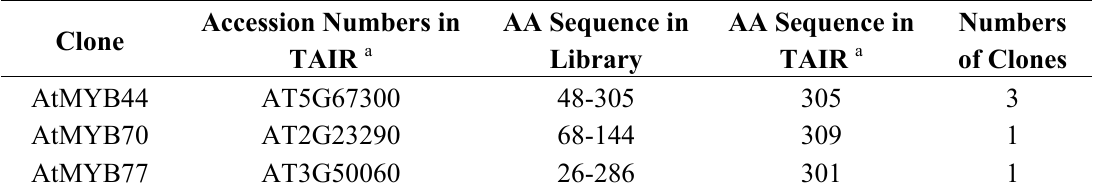
Table 1. RCAR1-interacting R2R3-type MYB transcription factors obtained by yeast two-hybrid assay in Arabidopsis